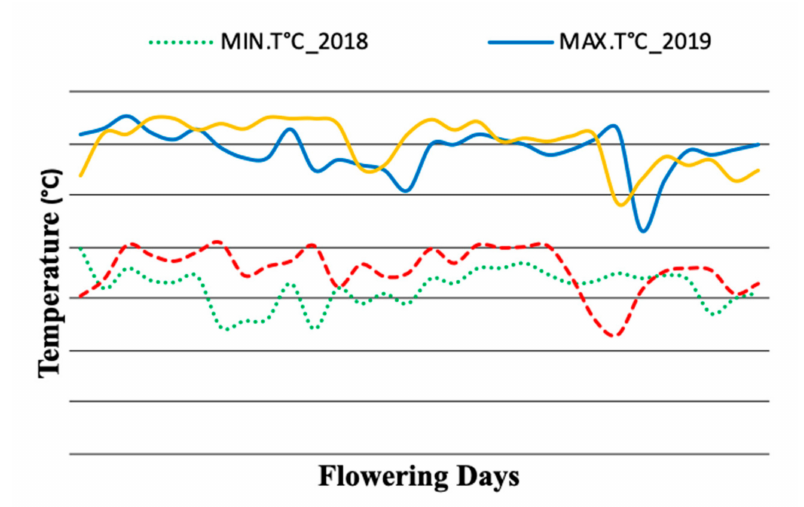
Figure 1. Mean temperature record for April 2018 and 2019 flowering days at Kadawa.